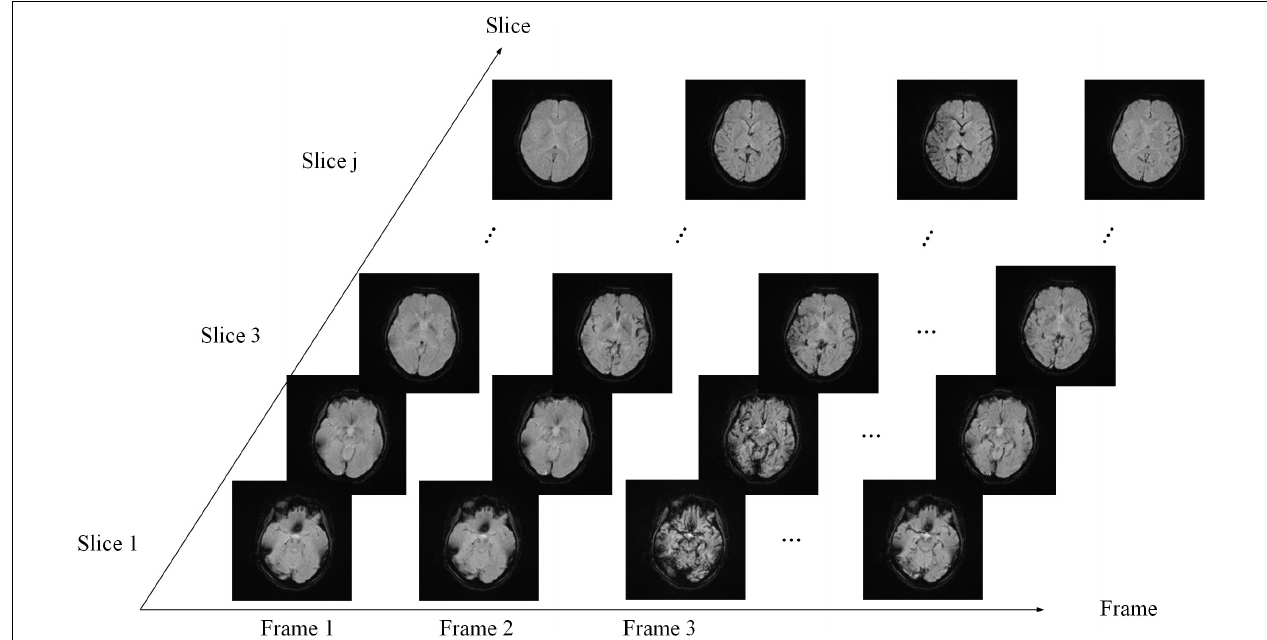
FIGURE 3 | Data sequence order. The sequence is arranged slice by slice in each frame and then arranged frame by frame.